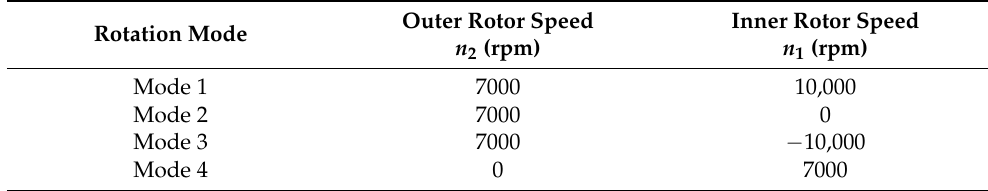
Table 4. Four inner and outer rotor rotation